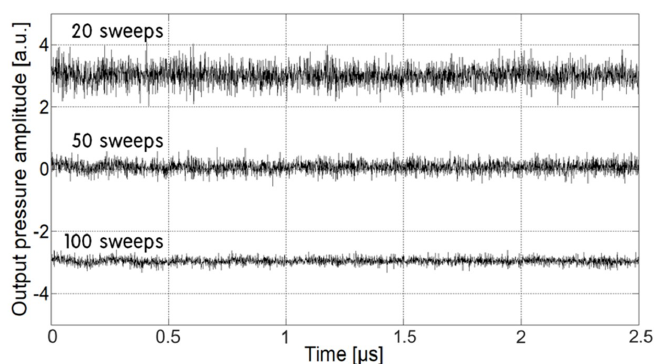
Figure 2. Background noise of the photoacoustic energy sensor (PES) system without pulsed laser irradiation. The noise level can be decreased by taking the average of greater numbers of sweeps.